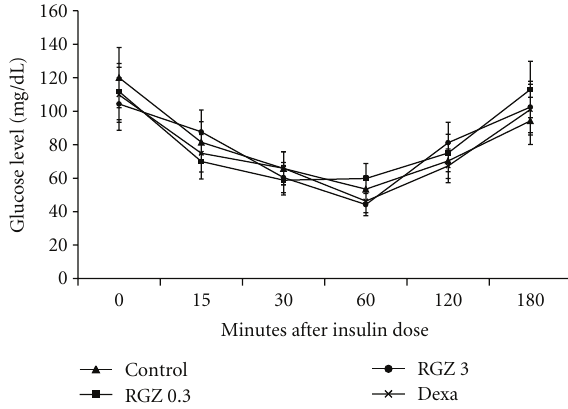
Figure 1: E ff ect of RGZ on postnatal weight gain. RGZ was admin- istered prenatally at doses of 0.3 mg/kg and 3 mg/kg i.p. × 2 doses. Another group was treated prenatally with i.p. dexamethasone (Dexa, 0.25 mg/kg) × 2 doses. Weight was recorded every 2 weeks starting at week 4 until week 14 and on the day of sacrifice. There were no significant di ff erences between study groups through out the observation period.